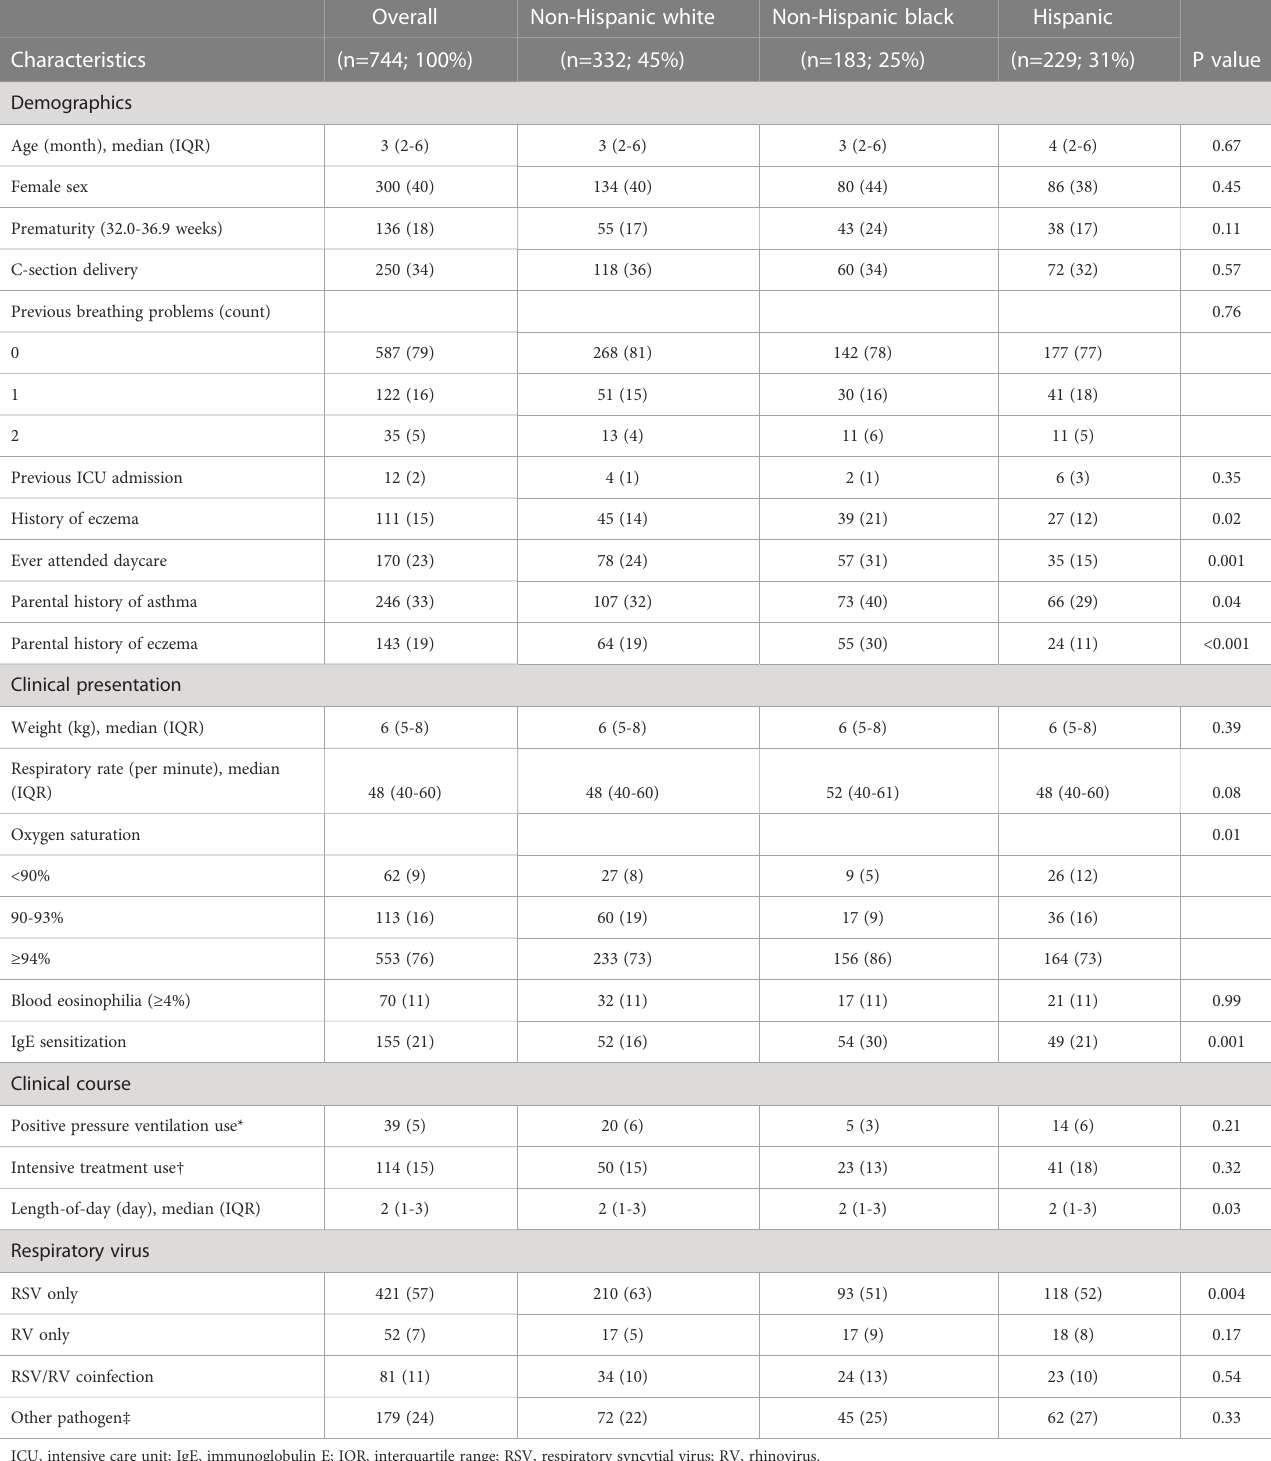
TABLE 1 Baseline characteristics and clinical course of 744 infants hospitalized with bronchiolitis, according to race/ethnicity. Overall Non-Hispanic